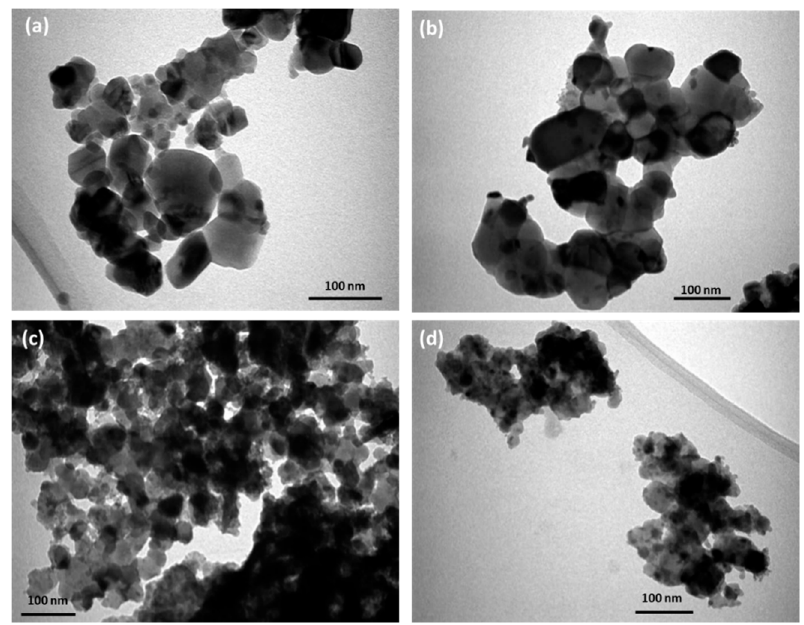
Figure 2. TEM images of ( a ) 0.0, ( b ) 0.01, ( c ) 0.03, and ( d ) 0.05 for Yb and Ce co-doped ZnO NPs.